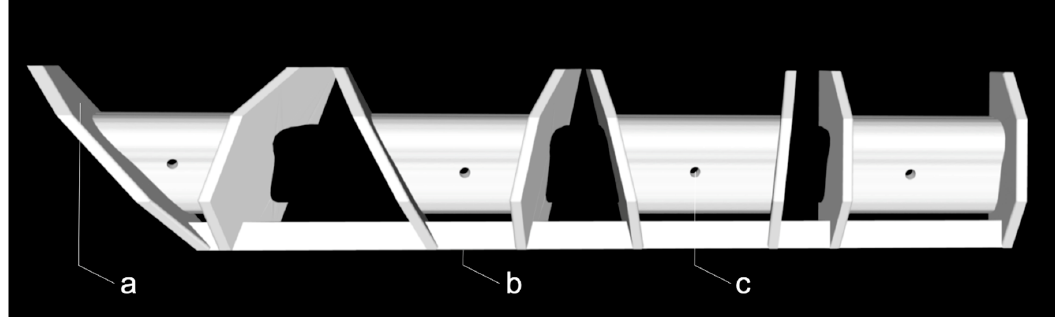
Figure 2. The 3D-printed cutting guide used in this study with simple stops ( a ), a connector to define the distance between the graft sites ( b ), and holes for screw fixation ( c ) per segment.